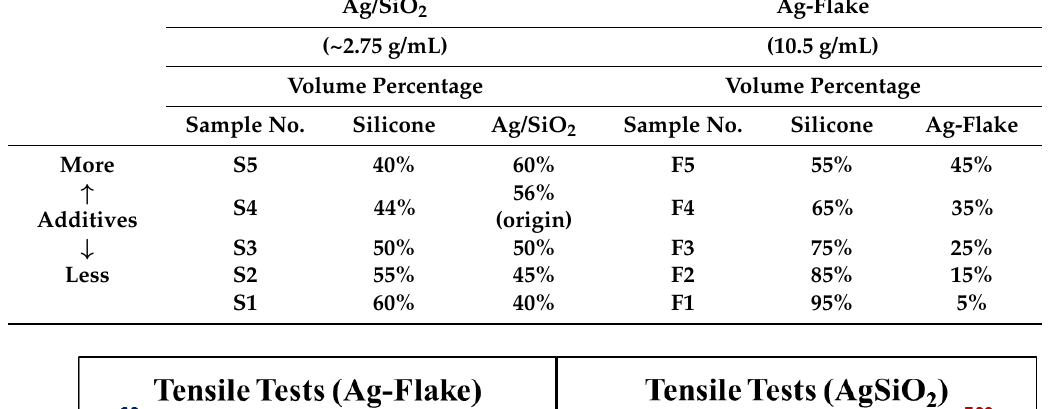
Table 1. The list of several samples of different proportions of additives (Ag/SiO 2 and Ag-flake).